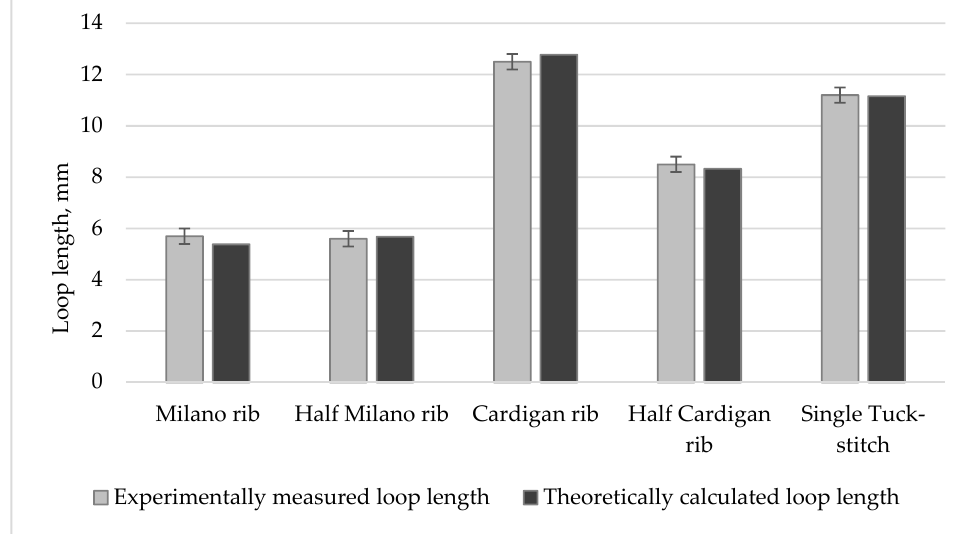
Figure 4. Comparison of theoretically calculated and experimentally measured loop lengths.